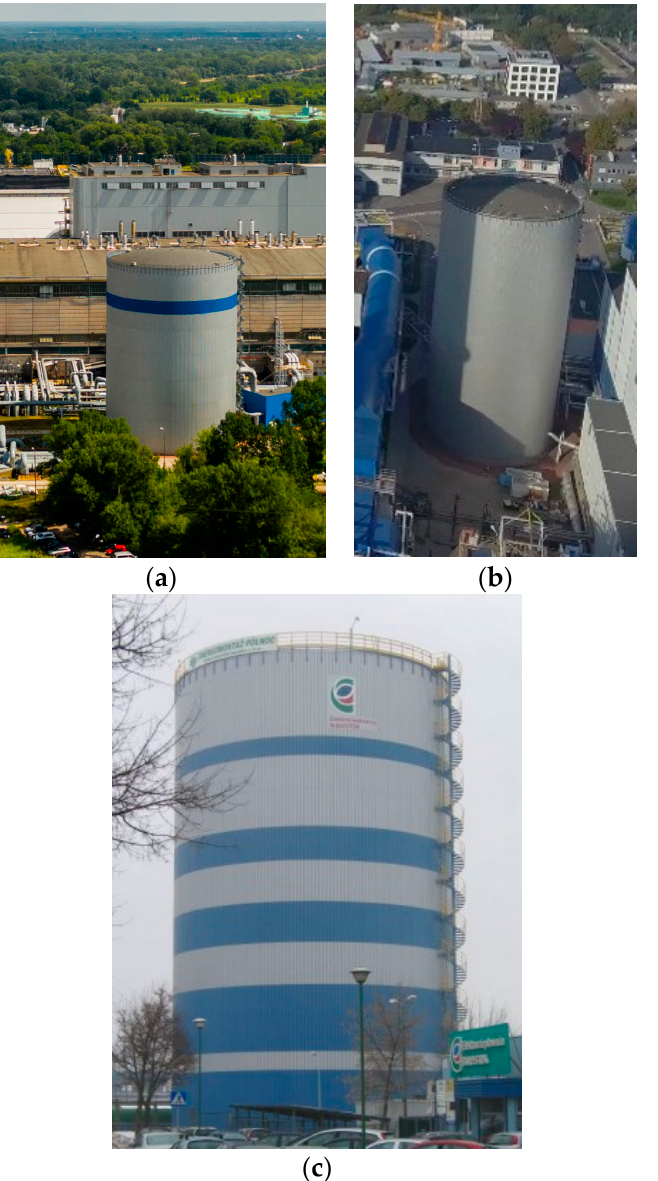
Figure 1. TES in ( a ) Siekierki CHP plant in Warsaw, ( b ) Cracow CHP plant and ( c ) Bia ł ystok CHP plant.